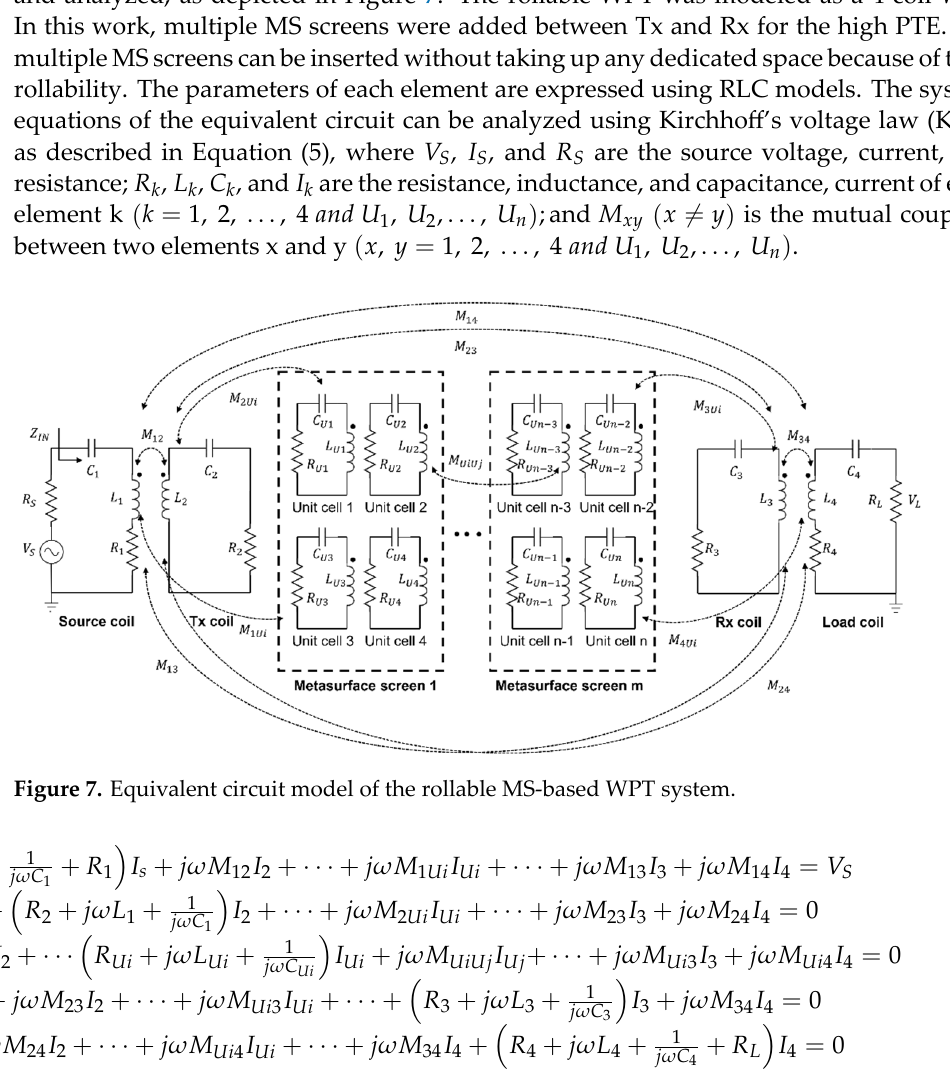
Figure 6. Simulated effective magnetic permeability of the MS screen.